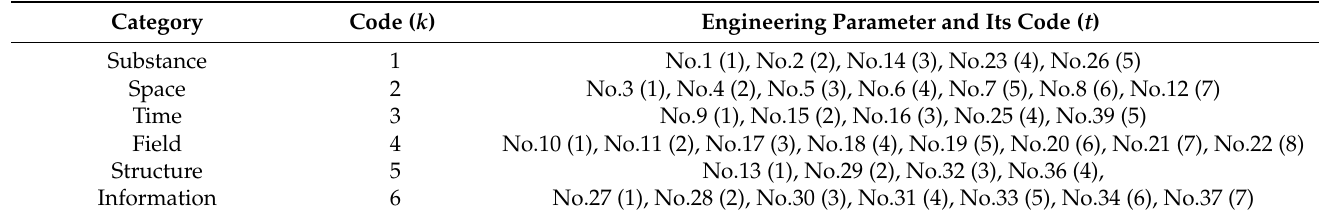
Table 4. Code of engineering